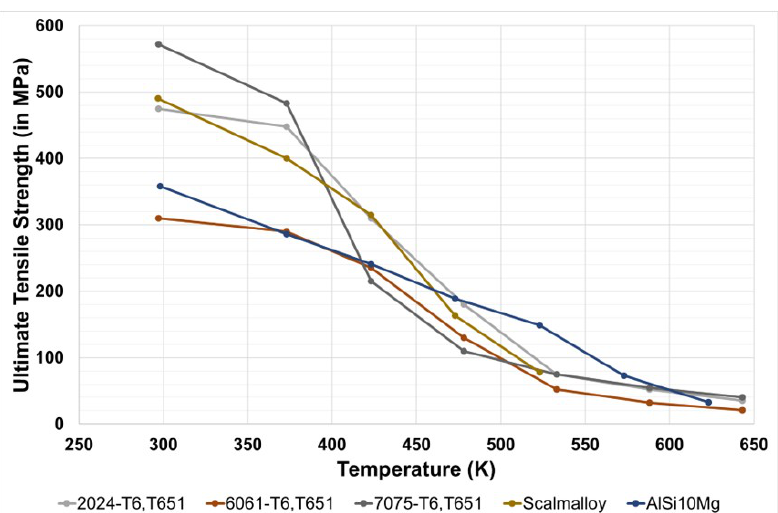
Figure 14. Deterioration of ultimate tensile strength of different conventional Al alloys as compared to AlSi10Mg, Scalmalloy ®